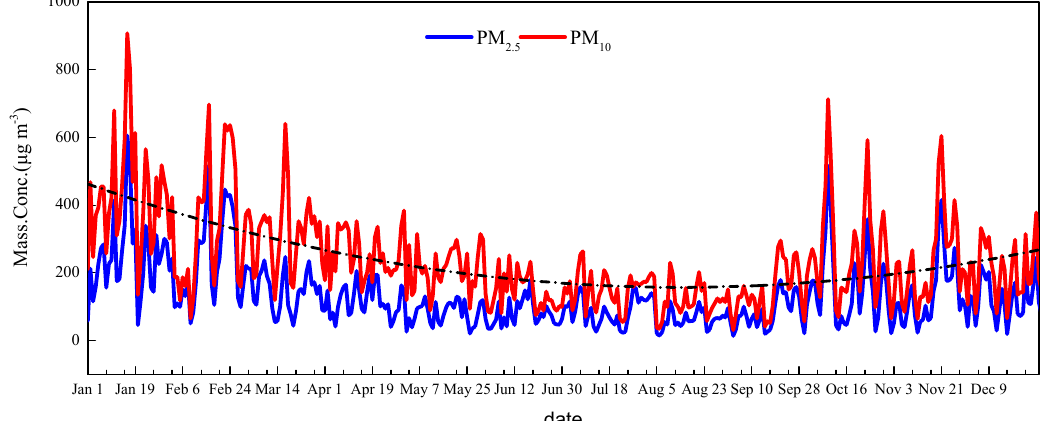
Figure 3. PM 2.5 and PM 10 mass concentrations from January 2014 to December 2014 (on-line data).